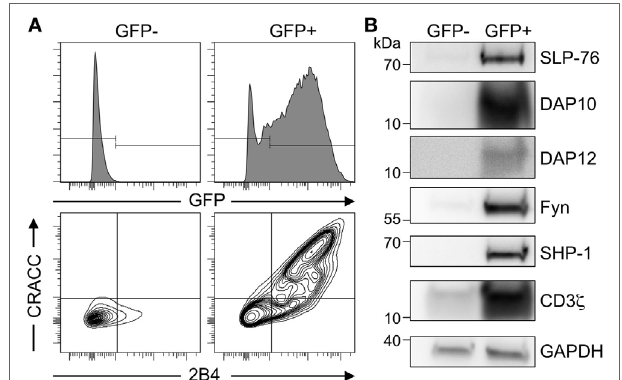
FigUre 1 | High co-transfection rate of multiple genes in transiently transfected Schneider cells. (a) Schneider S2-cells were co-transfected with plasmids coding for 2B4, CRACC, SLP-76, DAP10, DAP12, Fyn, SHP-1, CD3 ζ , and GFP. Expression was induced by CuSO 4 . After 36–48 h GFP − and GFP + cells were enriched by cell sorting and analyzed by FACS for expression of GFP, 2B4, and CRACC. Results are representative of three independent experiments. (B) Western blot analysis of co-expressed proteins in the total cellular lysate of transiently transfected S2 cells from (a) enriched for GFP − and GFP + by cell sorting. GAPDH was used as a loading control. Results are representative of five independent